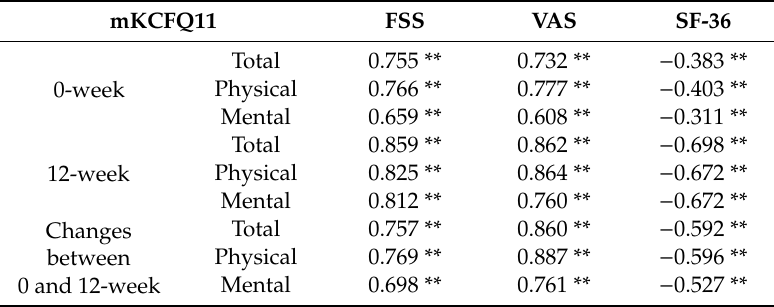
Table 3. Correlation between the mKCFQ11 and the FSS, VAS or SF-36 on 0 and